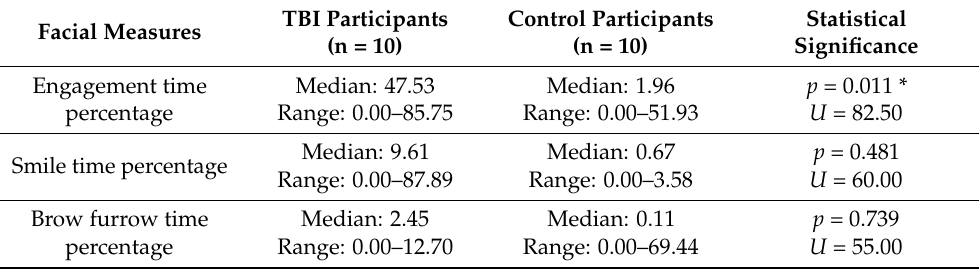
Table 6. Comparison of TBI and control participants on personal event narrative.